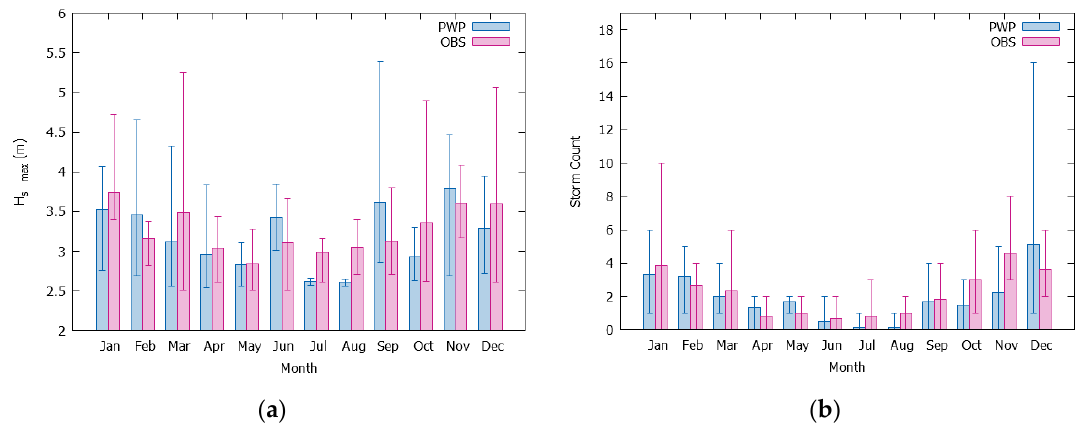
Figure 7 . Comparison of observed and modelled “present” annual averaged monthly 𝐻 𝑠 max and storm count for West Gabbard. ( a ) 𝐻 𝑠 PWP compared to the observed; ( b ) storm count PWP compared to the observed.